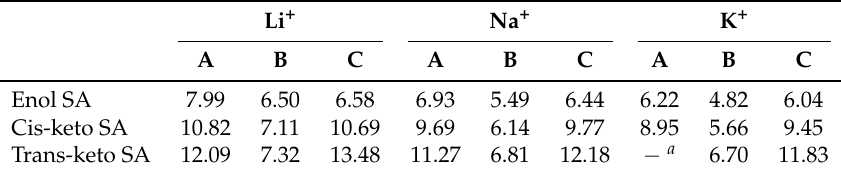
Table 2. Dipole moment (in Debye) of the SA molecule in complexes A to C (Figure 1) with the Li + , Na + and K + ions computed at B3LYP